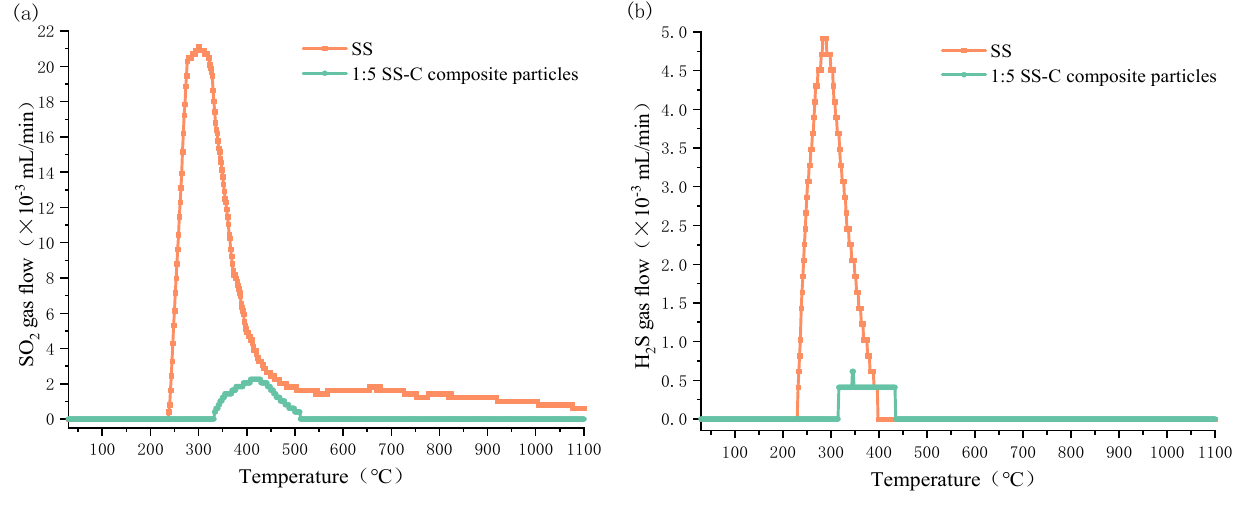
Figure 6. Release of SO 2 and H 2 S gases from SS and 1:5 SS-C composite particles at different temperatures; ( a ) SO 2 ; ( b ) H 2 S.